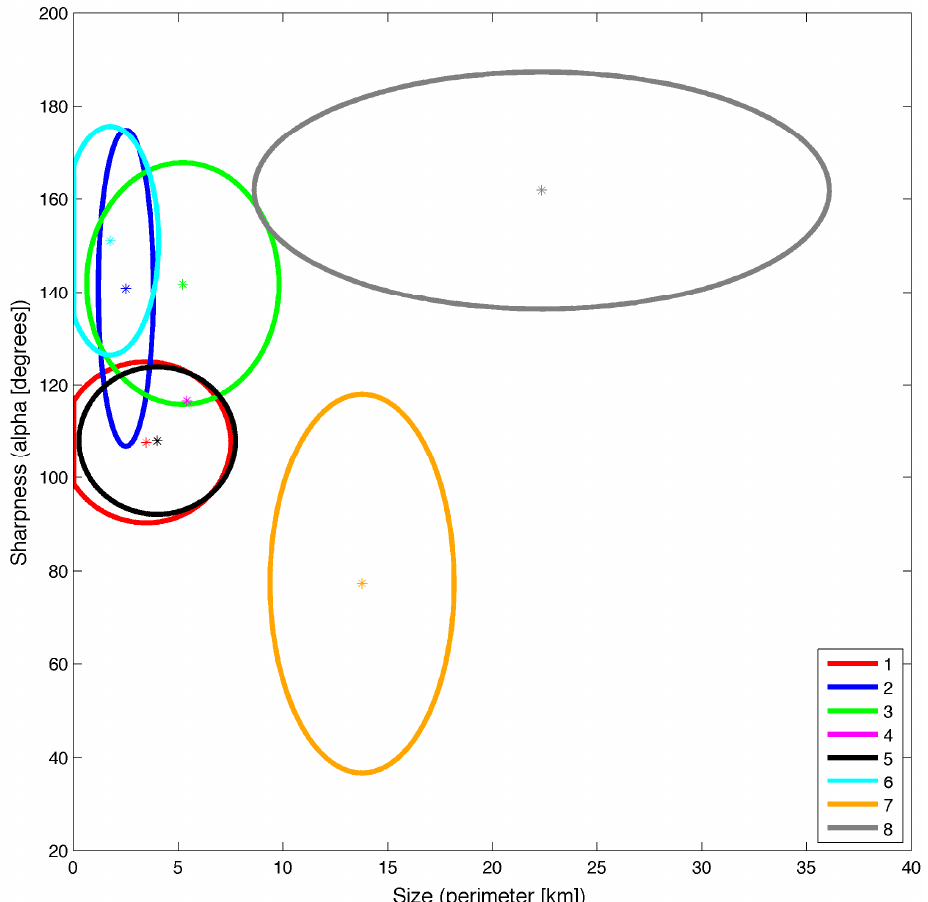
Figure 2. Size and sharpness of the eight headland classes developed by George, Largier, Storlazzi, and Barnard [27] . Four idealized headlands were developed for modeling using the dimensions of T1, T6, T7, and T8. For examples of the classes, see George, Largier, Storlazzi and Barnard